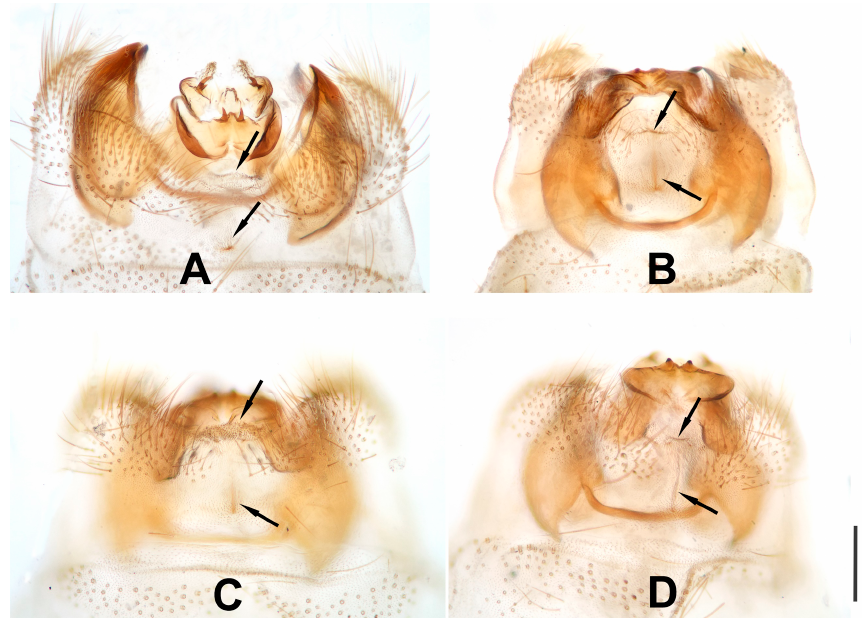
Figure 16. Dilar maculosus Zhang, Liu, H. Aspöck and U. Aspöck, 2015, male tergum 9, ventral view, photographs. ( A ) holotype, China: Yunnan, Baoshan, Nankang; ( B – D ) China, Yunnan, Baoshan, Nankang, Gaoligong Natural Park. Arrow indicating the weakly sclerotized and protruded at posteromedially of tergum 9. Scale bars: 0.2 mm.